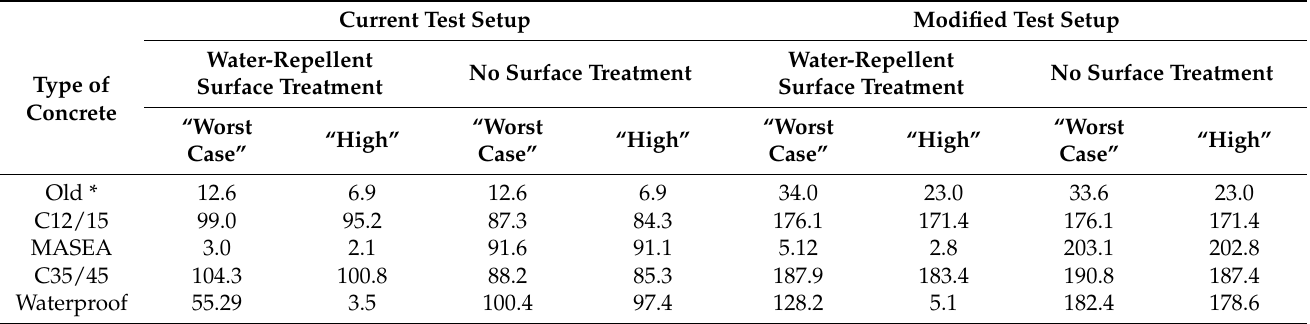
Table 4. Moisture content in PIR insulation after one year of accelerated